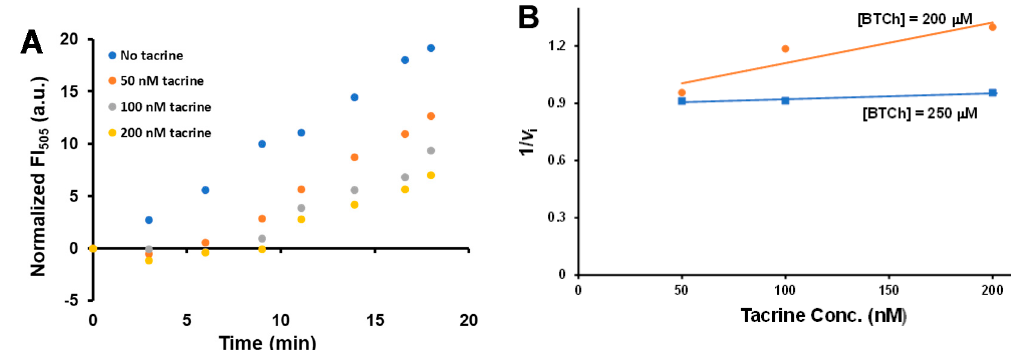
Figure 5. Tacrine inhibition on BChE catalysis analyzed by the fluorescence assay based on 11 . ( A ) Time-course kinetic analysis of tacrine inhibition on BChE (182.2 U L − 1 ) catalysis was performed in the presence of BTCh (200 µ M) in PB. Each BChE reaction contained 0, 50, 100, or 200 nM of tacrine. ( B ) Dixon plot of the inhibitory kinetics of tacrine on BChE catalysis was delineated according to v i from Figure 5A and Supplementary Materials Figure S7. The tacrine inhibitor constant K i was determined from the minus x -axis value at which the two extrapolated lines intersected and was 5 nM in this study.